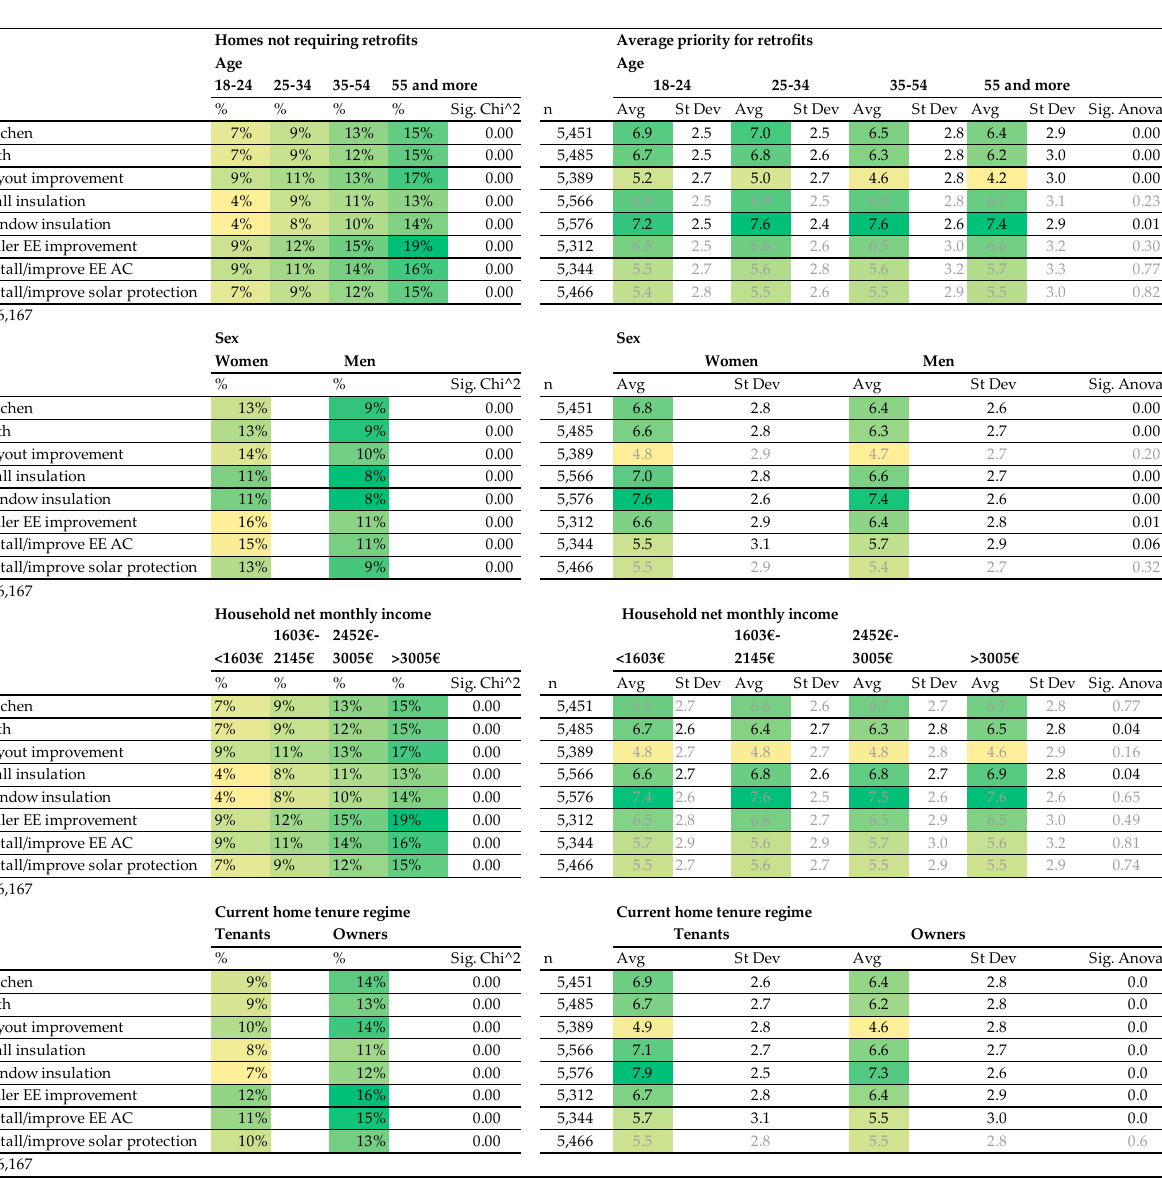
The gradient color from soft yellow to dark green correspond to the numerical values gradient, from lower to higher ones. Figure 6. Retrofit requirements and priorities according to respondents’ sociodemographic profile. Source: Self elabora- tion.